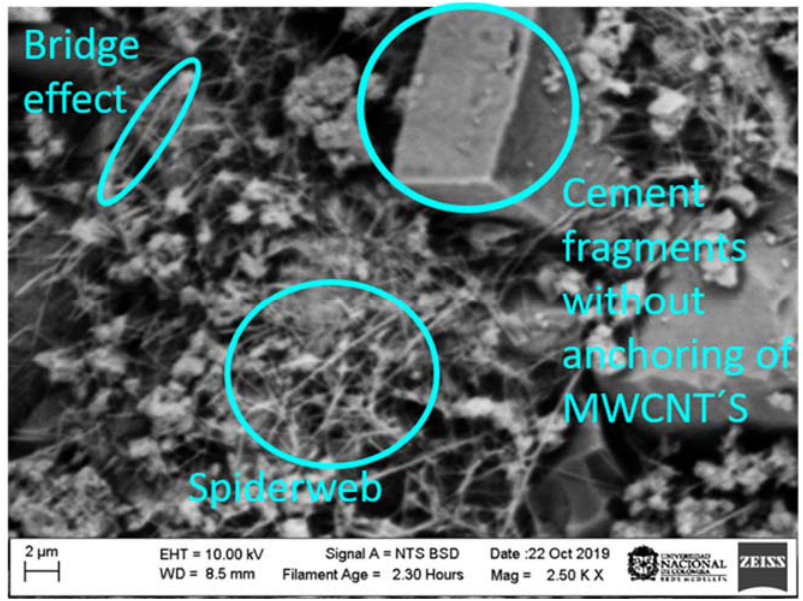
Figure 12. SEM image obtained for a cement paste after the compressive test. This image was taken of sample S3.